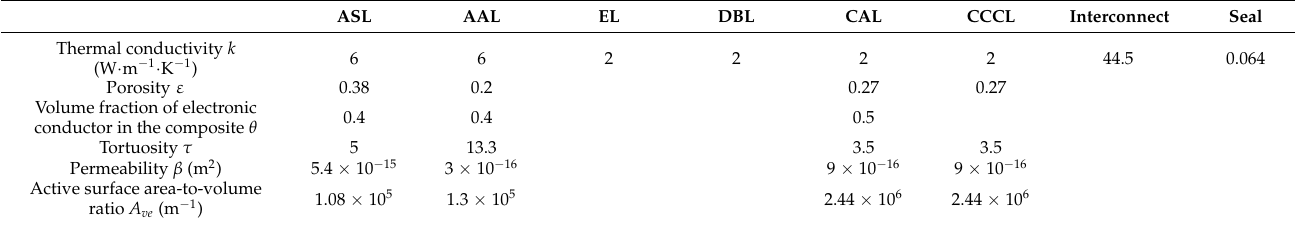
Table 4. Properties for different components of the SOFC [8].